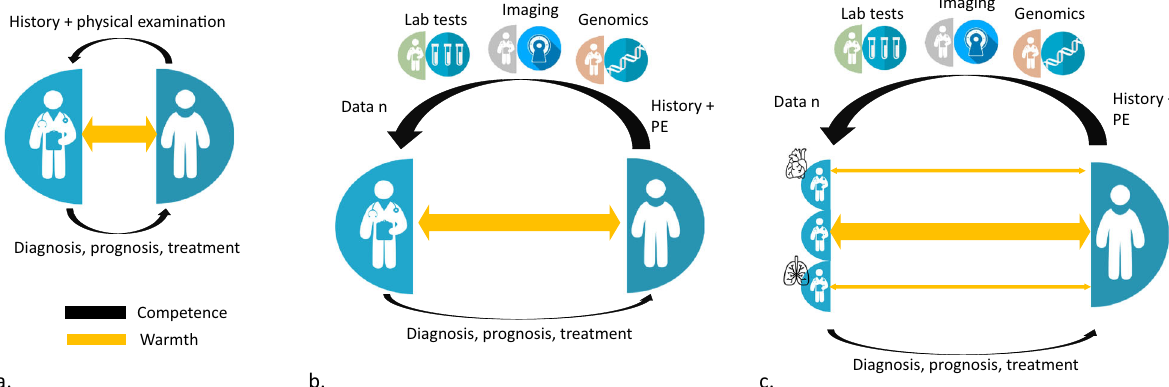
Fig. 1 Competence and warmth in the era of data revolution. a Until the early twentieth century, physicians collected data from history and physical examination to diagnose conditions, estimate prognosis, and/or treat their patients (competence) while establishing a singular relationship with them (warmth). b The data revolution was marked by the increasing use of machines which led to a division of labor in data collection, with the involvement of biologists, radiologists, geneticists, etc. c The accumulation of knowledge led to the emergence of specialists and subspecialists, and medical decisions now often require multidisciplinary teams. Overall competence increased but the multiplication of organ specialists and the increasing place of machines threatened the physician – patient relationship. The concept of patient- centered care rebalanced competence and warmth. PE physical